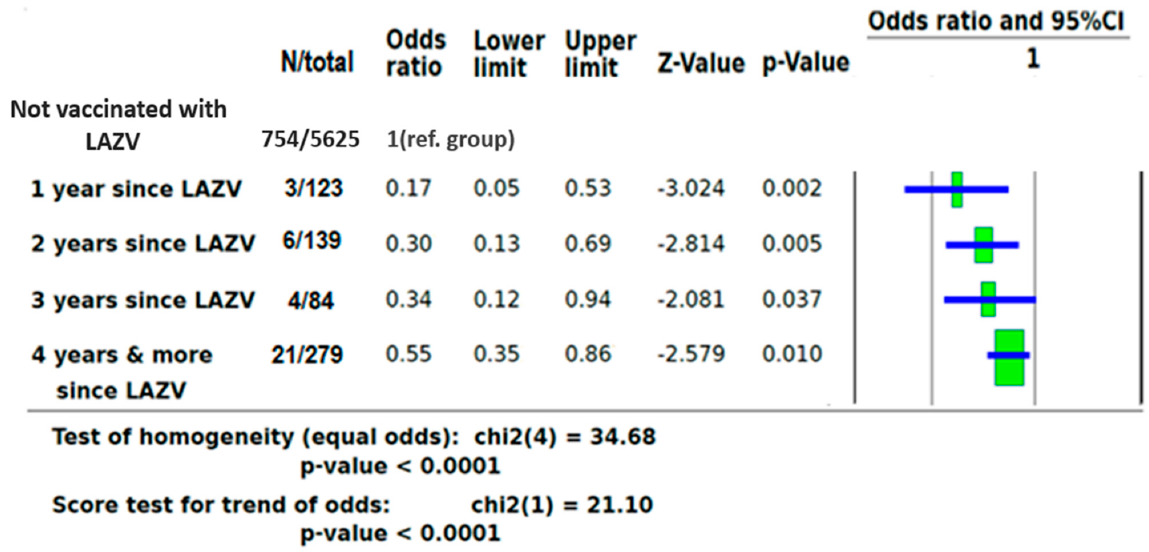
Table 3. Multivariate analysis of variables associated with COVID ‐ 19 infection.